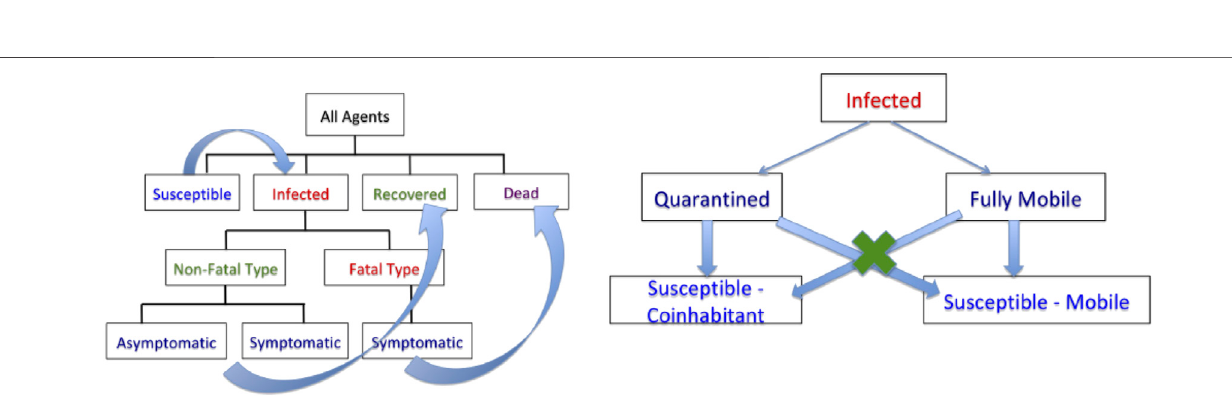
FIGURE 1 | Left: random walk model for agent motions. Middle: proximity-based spread of infections from infected to susceptible agents. Right: layout of households on a square grid in the center of the domain.